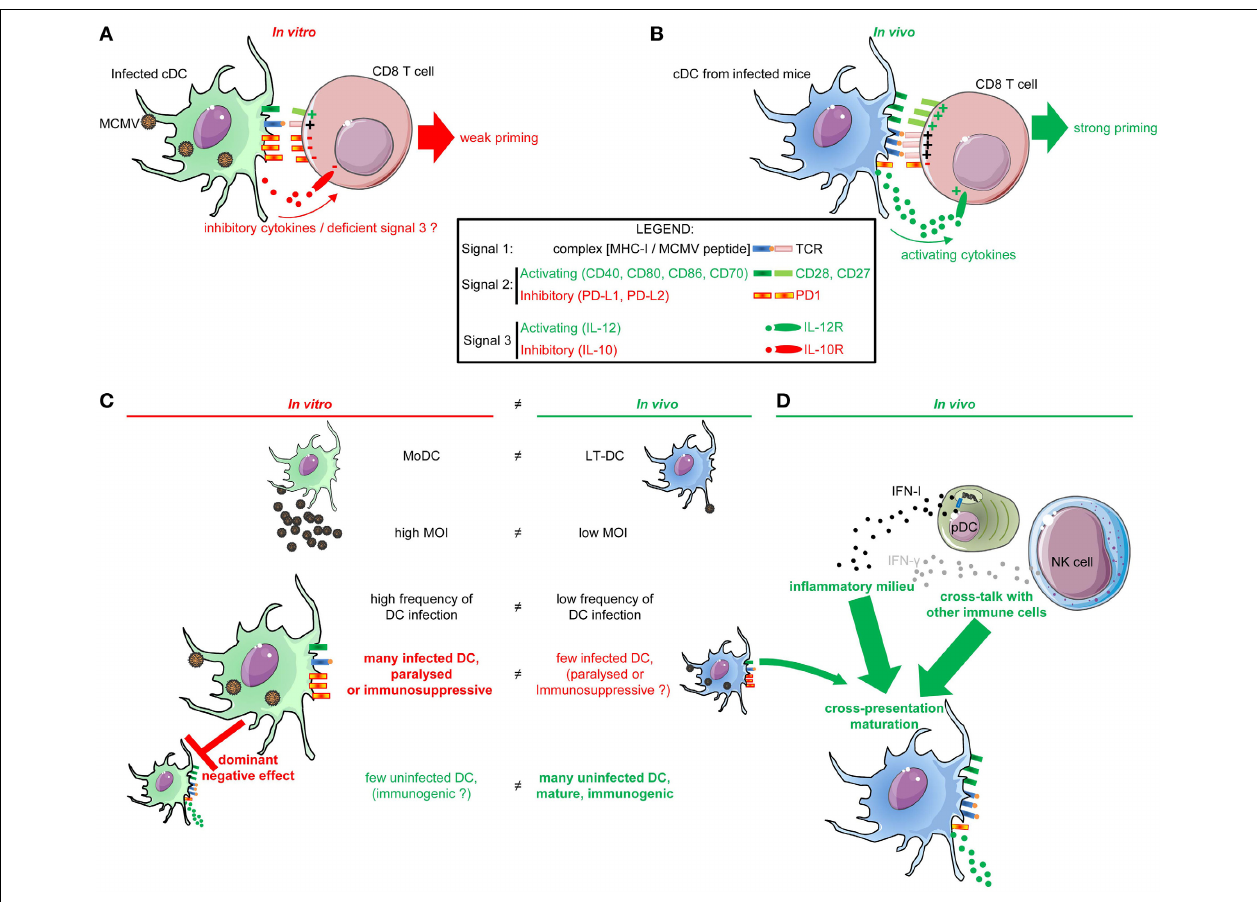
FIGURE 1 | DC functions are differentially impacted by their infection in vitro vs. the infection of mice in vivo . (A) Impact on DC functions of their infection by MCMV in vitro . In vitro , MCMV-infected DC are “paralyzed” by the virus which prevents them to deliver adequate signals 1 and 2 for antiviral CD8 T cell activation. Specifically, infected DC down-regulate their expression of MHC-I and activating co-stimulation (CD40, CD80, CD86) molecules as a consequence of their expression of viral immune evasion genes. They induce inhibitory co-stimulation molecules (PD-L1 and PD-L2). Hence, infected DC only weakly prime antiviral CD8 T cells. (B) cDC functions in vivo in MCMV-infected mice. cDC are very strongly activated by MCMV infection in vivo , in a way enabling them to induce potent T cell activation in vitro , and consistent with the fact that MCMV infection induces very strong and protective antiviral cellular immune responses in vivo .